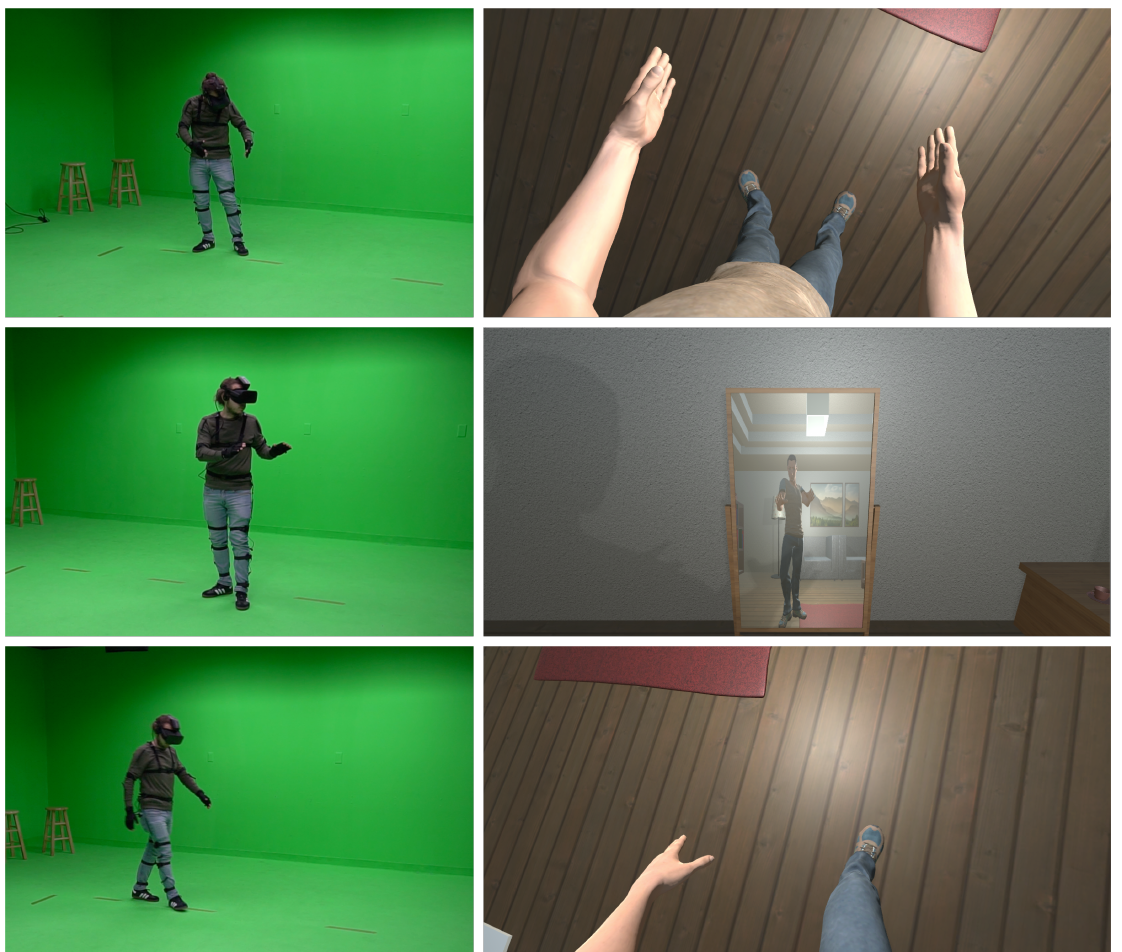
Figure 3. A participant observing his motion retargeted to the self-avatar that embodies him for the three developed tasks during the baseline